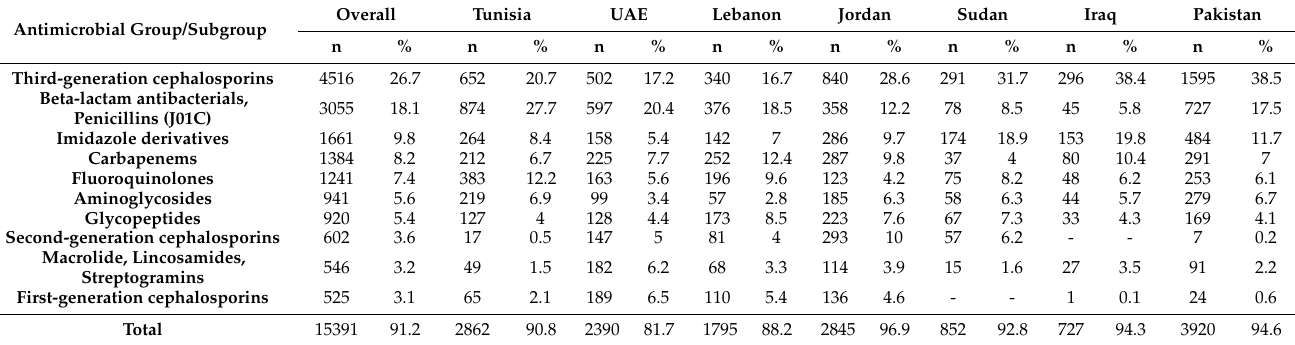
Table 1. Distribution of prescribed antimicrobial groups, seven countries in the Eastern Mediterranean Region,